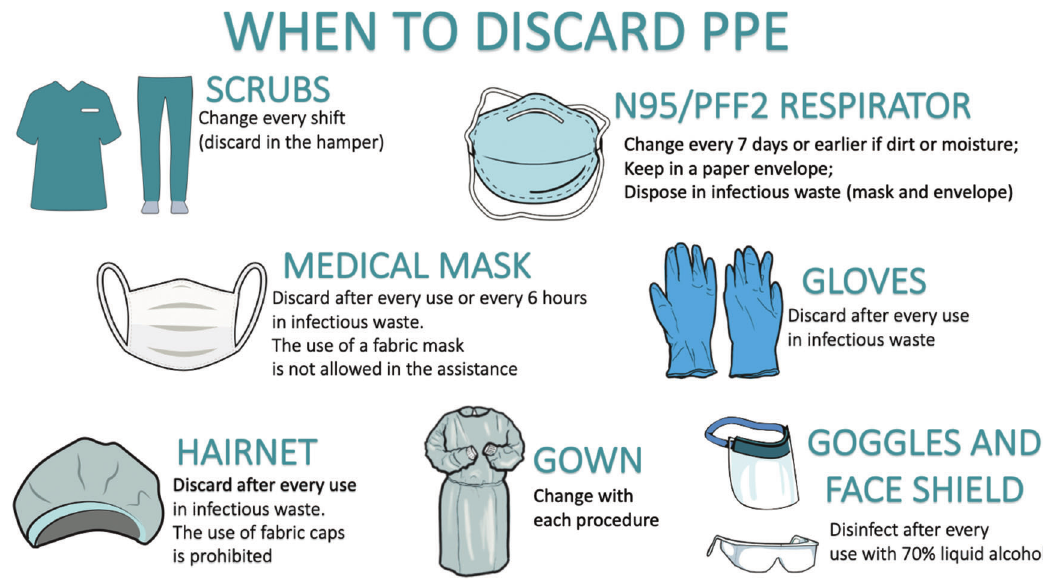
Figure 6 - PPE Disposal Suggestion. According to Hospital das Clı´nicas da Faculdade de Medicina da Universidade de Sa˜o Paulo (HCFMUSP) recommendations. Abbreviations: PPE, personal protective